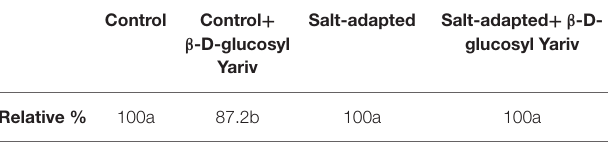
FIGURE 4 | Immuno-dot blot analysis with JIM13 on samples of control (C) and salt-adapted tobacco BY-2 cells (A) treated with the inhibitor of phospholipase C, U73122 and its inactive analog, U73343. Five samples per each treatment were collected from culture medium of cells growing during 24h.